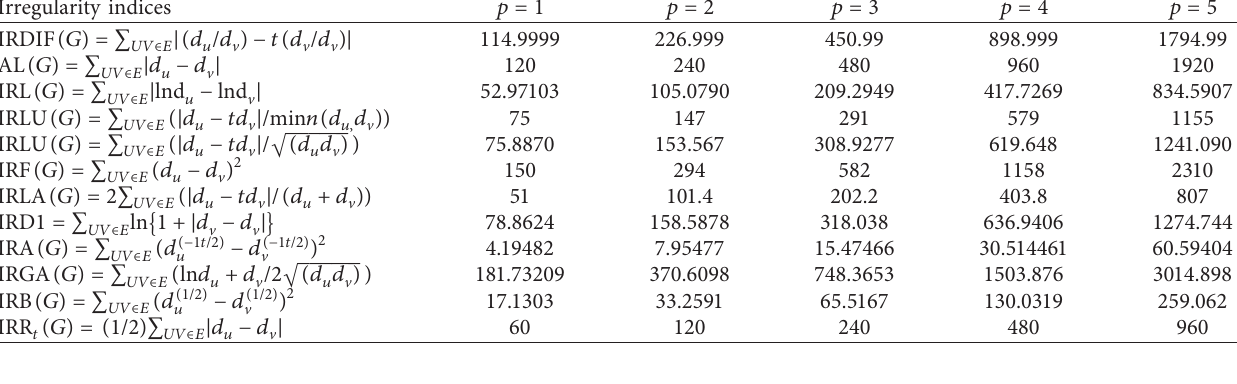
Table 6: Irregularity indices for polymer dendrimer NS